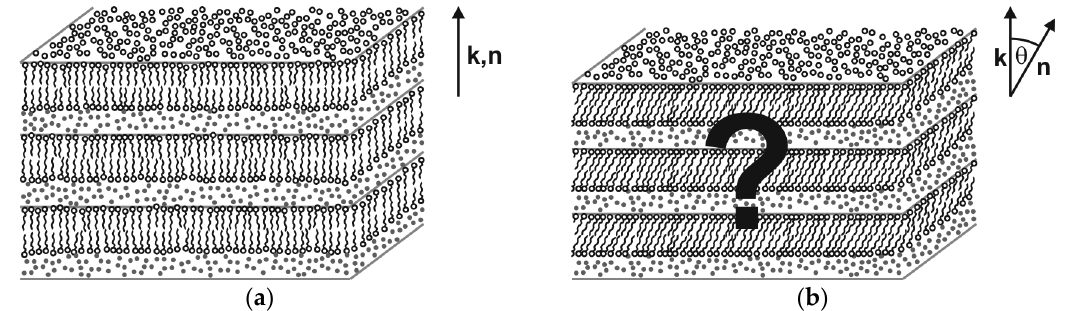
Figure 6. Lyotropic equivalents to the thermotropic fluid smectic phases SmA and SmC. ( a ) The lamellar α -phase (L α ) is a 1D-stack of 2D-fluid surfactant bilayers (lamellae) which are separated from each other by interlamellar solvent layers. Since the director n is parallel to the bilayer normal k , L α is the lyotropic equivalent to thermotropic SmA. ( b ) The lyotropic equivalent to the thermotropic SmC phase should have the same fundamental structure as L α except that the surfactant molecules are tilted by the tilt angle θ into the same direction in all bilayers (synclinic tilt correlation). (Reprinted by permission from Springer Nature: [13].)